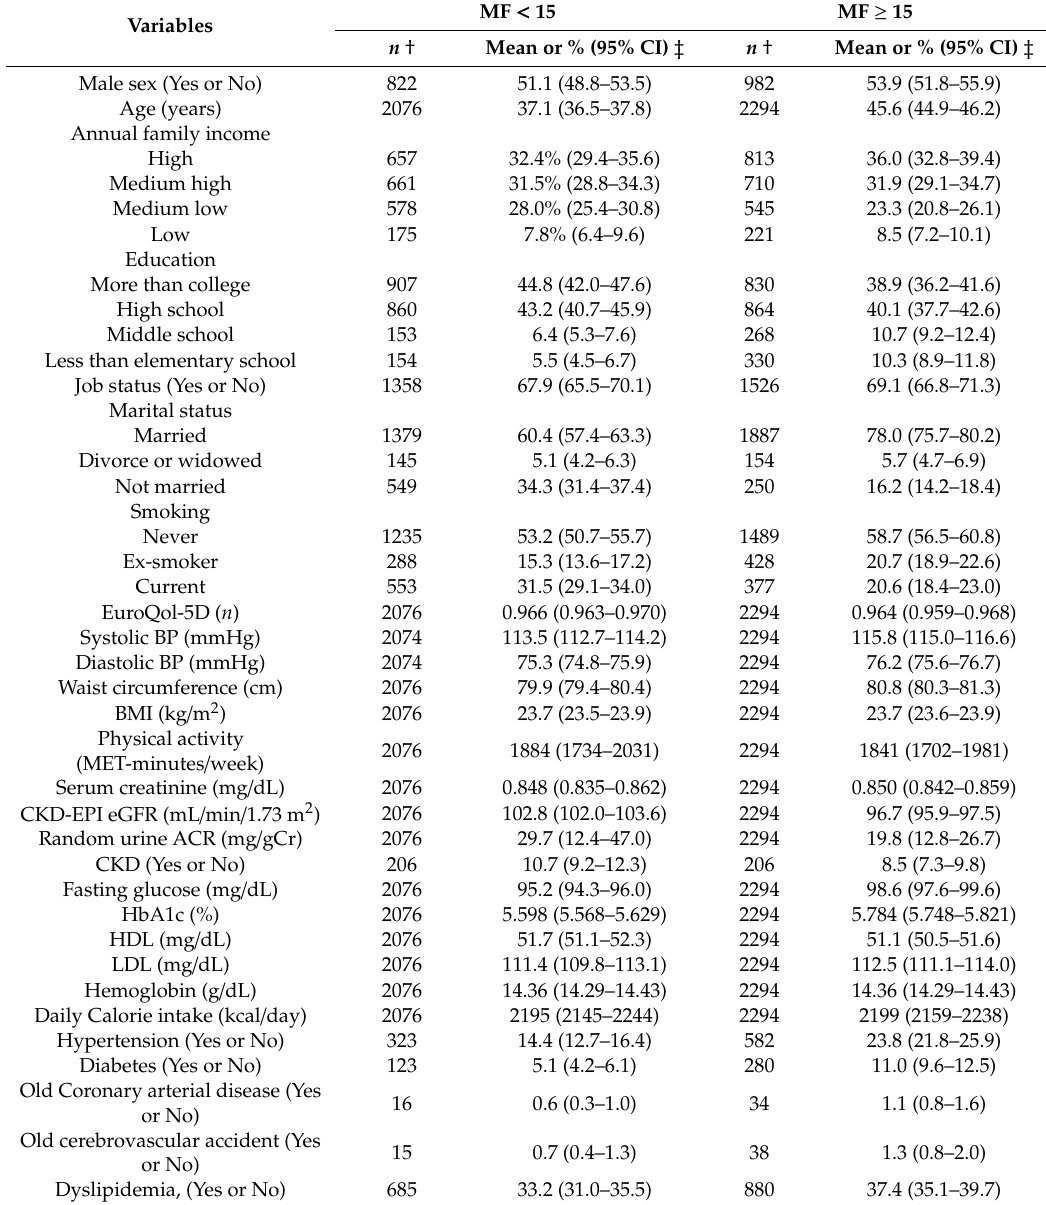
Table 1. The concise baseline characteristics of population by meal